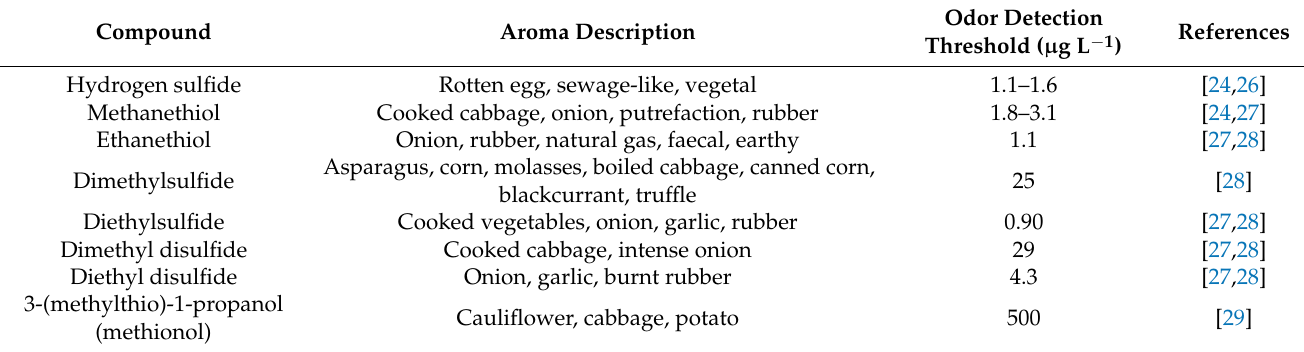
Table 1. Selected sulfur volatile compounds and their detection